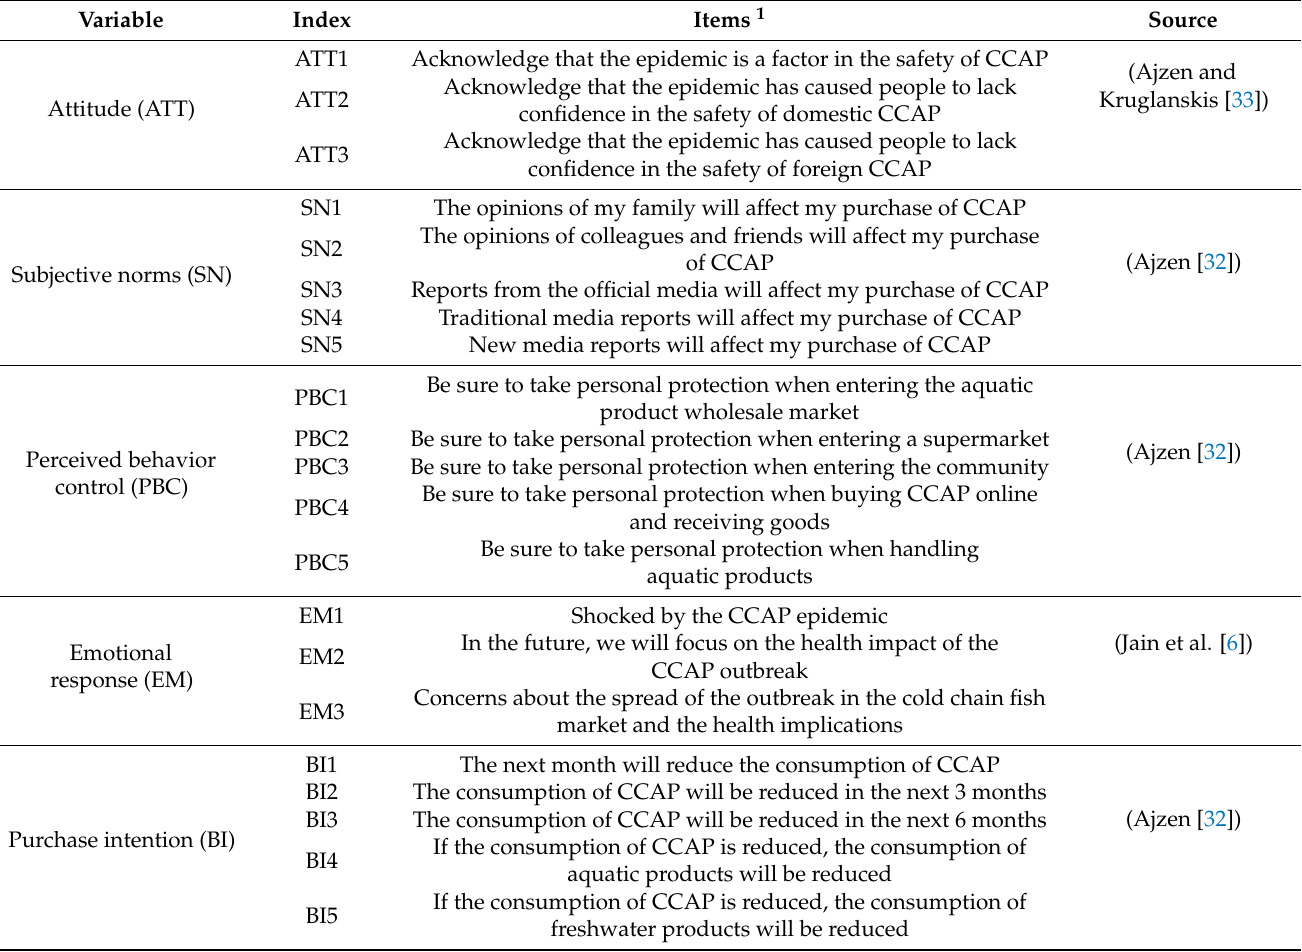
Table 1. Measurement variables and sources.